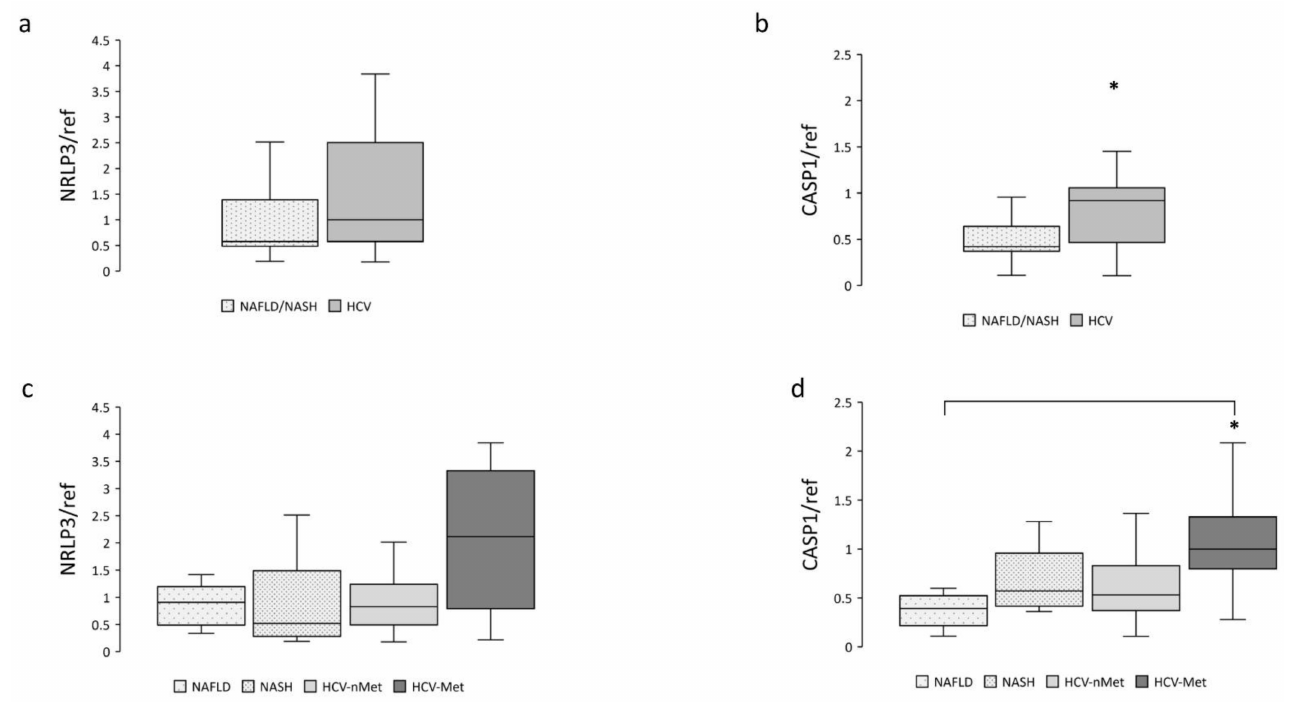
Figure 2. Hepatic NRLP3 and CASP1 gene expression in the main study groups ( a , b ) and the four subgroups ( c , d ). Data are normalized to GAPDH expression. * p <